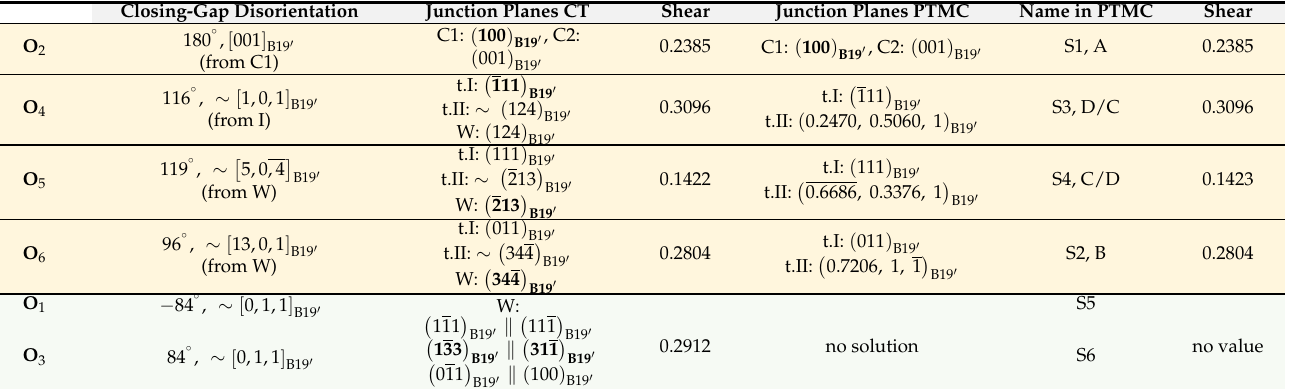
Table 5. Comparison between the CT and the PTMC to predict the B19 (cid:48) junction planes associated with the operators O i . The letters t.I, t.II and C mean “type I”, “type II” and “compound” twins, respectively. In the column “Name in PTMC”, notation with the letter “S” was used by Hane and Shield [51] and notation with a letter (A, B, etc.) by Bhattacharya [2]. For the correspondence theory, the letter W means “weak twin”. The junction planes experimentally observed are written in